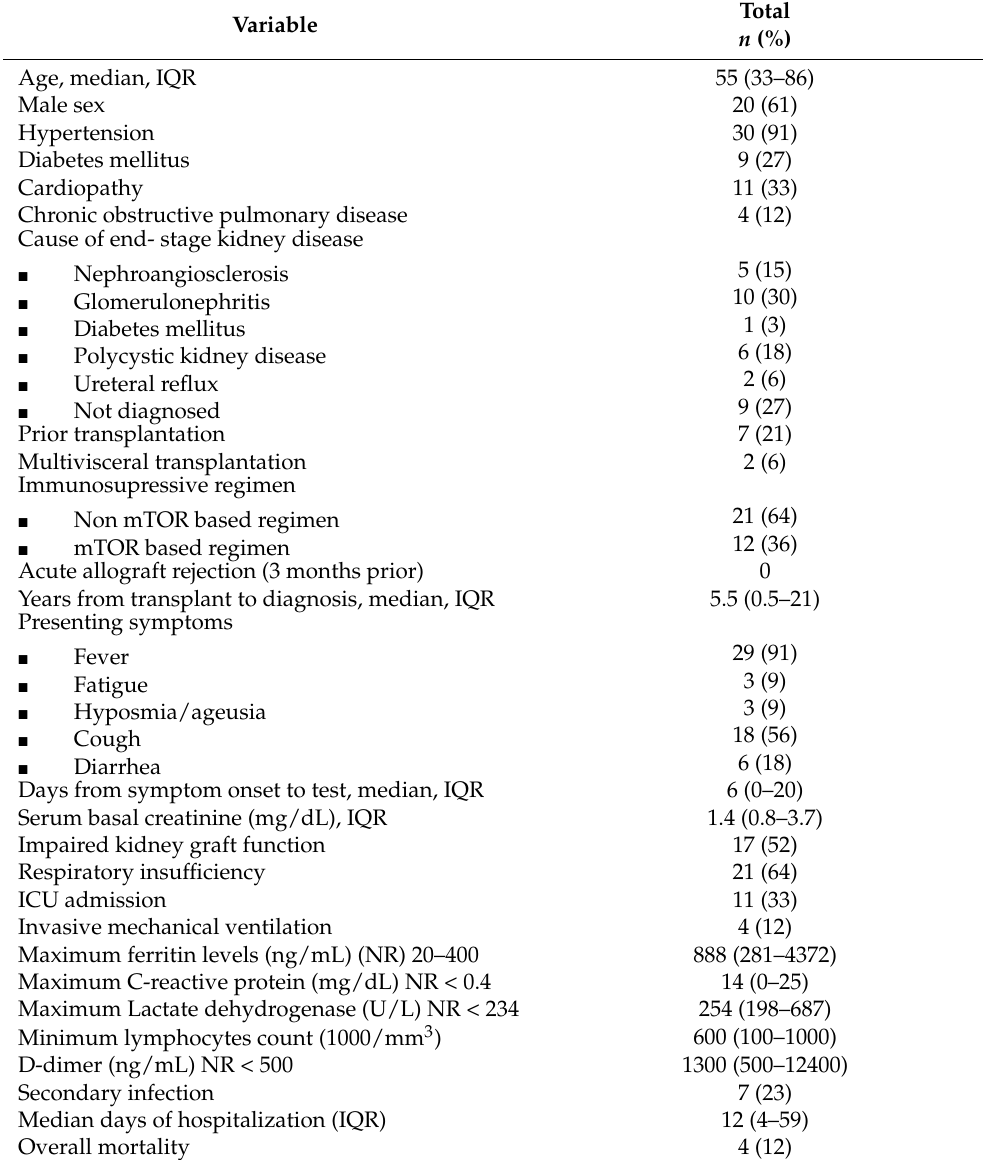
Table 1. Baseline characteristics of kidney transplant recipients hospitalized due to coronavirus disease 2019